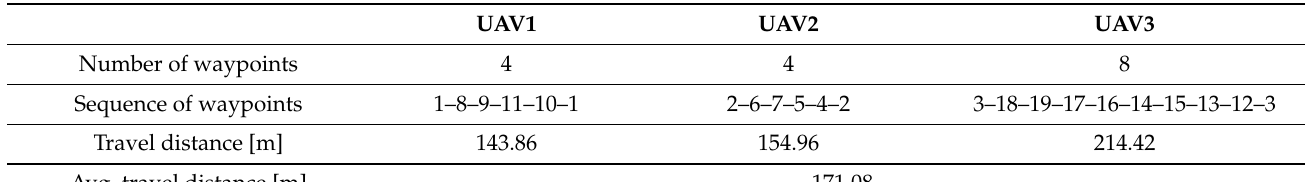
Table 1. Task assignment results for the sample configuration.